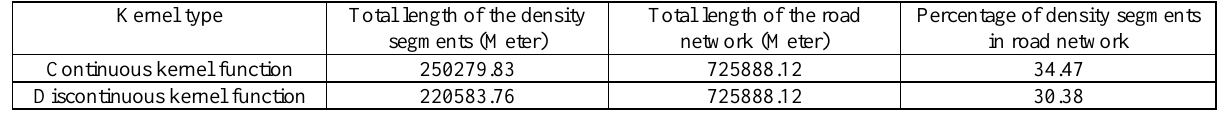
Table 1. Comparison of the length density segments resulting from the NKDE method with the two kernel functions